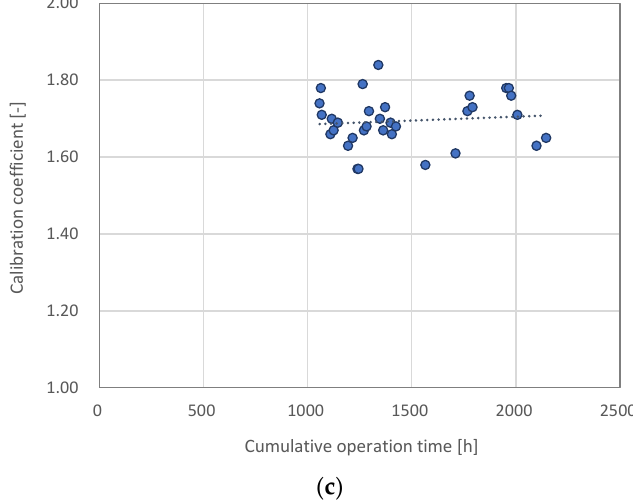
Figure 2. Calibration coefficient values according to cumulative operation time of heat source equipment: ( a ) Ch-1; ( b ) Ch-2; ( c ) Ch-3.